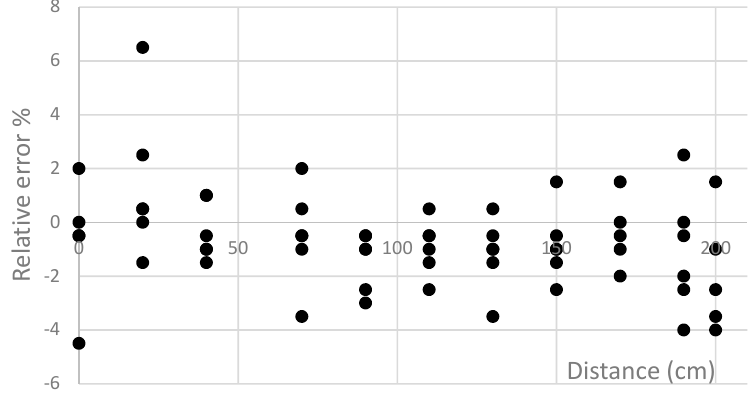
Figure 8. The dependence of error on the position of sensors with respect to vehicles using the second method.